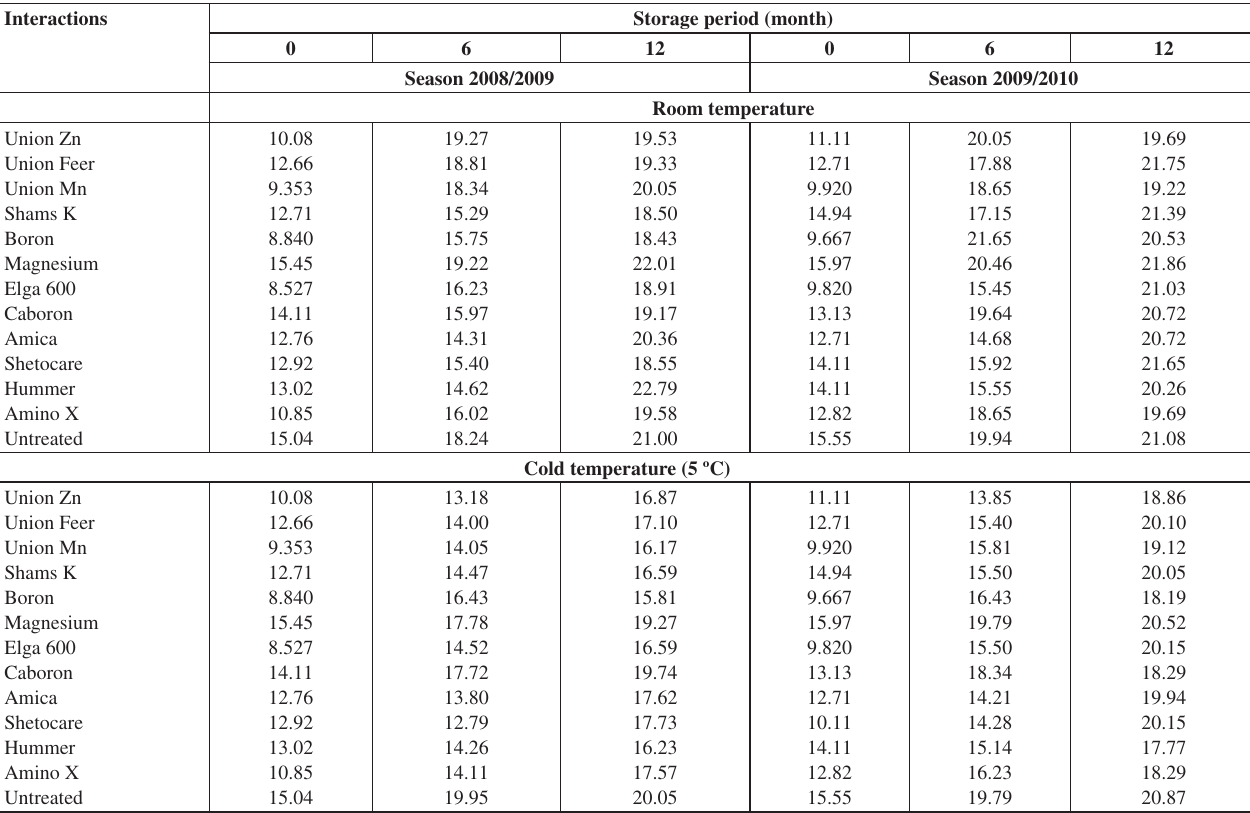
Table 26: Effect of the interaction between storage temperature, storage period and foliar application with commercial compounds on malondialdehyde content of onion seeds during seasons of 2008/2009 and 2009/2010